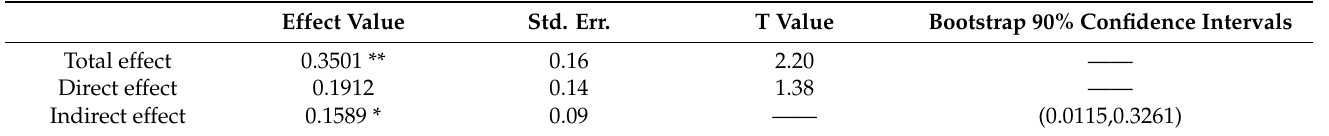
Table 6. Direct and indirect effects of forestland use right on forest